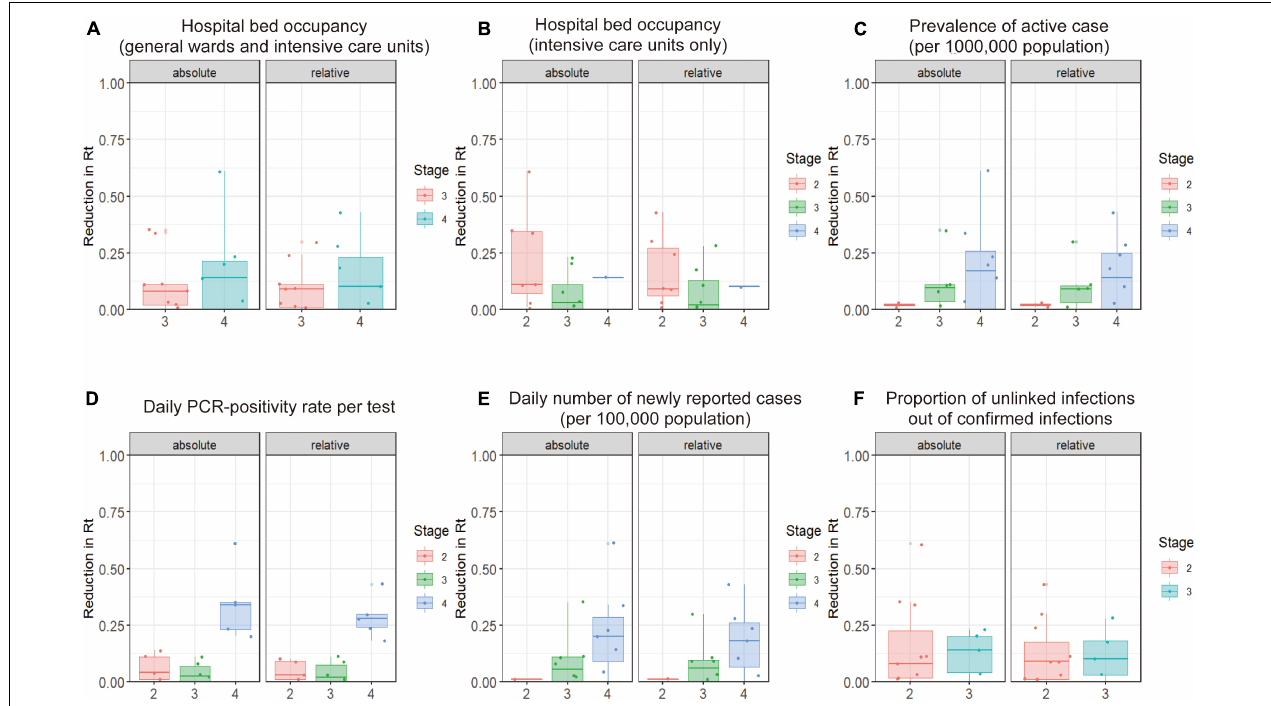
FIGURE 3 | Relationship between prefectural COVID-19 epidemic stage at the start of pre-emergency measures (PEM) and reduction in the effective reproduction number ( R t ) during the PEM period compared with the 7 days before intervention (baseline period). This figure shows the relationship between the reduction in R t during the 7 days prior to the intervention and during the 7 days after the intervention and the epidemic stage at the time of the intervention. The horizontal axis is the “stage” of the COVID-19 epidemic, according to definitions of the Japanese government. (A,B) Hospital-bed occupancy is defined as stage 3 when 20% of COVID-19 beds are occupied and stage 4 when 50% of beds are occupied. (C) The prevalence of active cases is defined as the number of patients who are hospitalized or under observation at home. Twenty or more cases per 100,000 population in a prefecture is defined as stage 3, and 30 or more cases is defined as stage 4. (D) The daily PCR-positivity rate is defined as stage 3 with 5% or more positive test results among the total tests and stage 4 with 10% or more. (E) The daily number of newly reported cases is defined as stage 3 with 15 or more newly reported cases per 100,000 population and stage 4 with 25 or more newly reported cases per 100,000. (F) The percentage of unlinked cases is defined as 50% or more for stage 3 and less than 50% for stage 2. The left-hand panel shows the absolute reduction in the effective reproduction number ( R t ) and the right-hand panel shows the relative reduction. We calculated p-values using analysis of variance or the Wilcoxon signed-rank